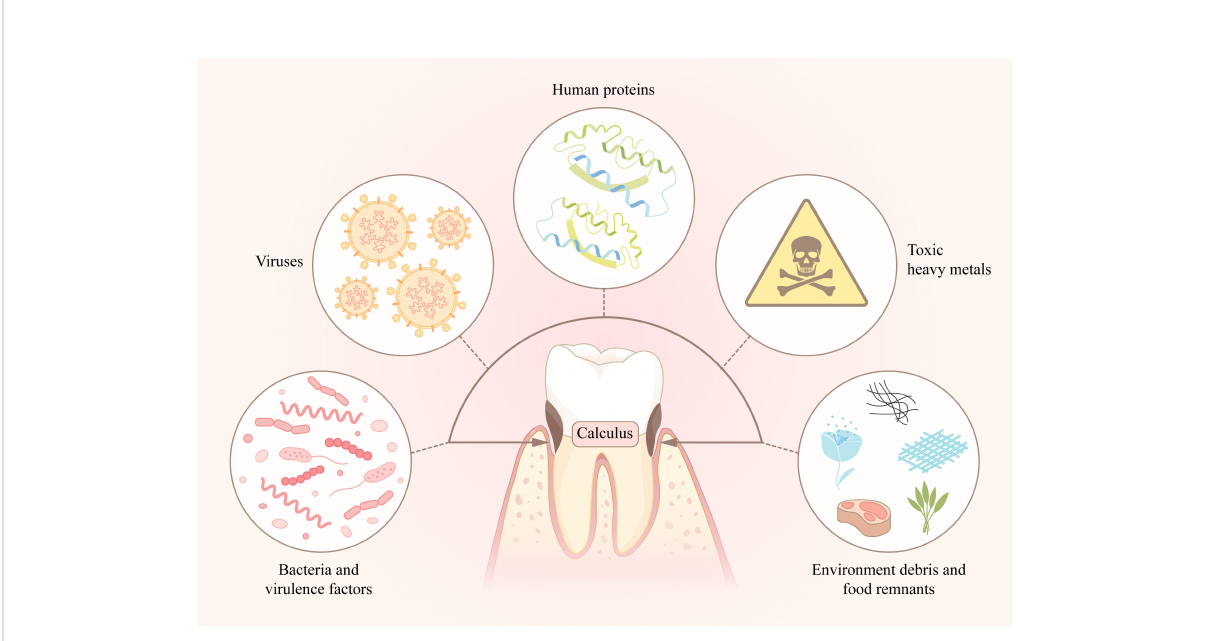
FIGURE 1 The absorbates in dental calculus, including oral bacteria and its virulence factors, human proteins, viruses, toxic heavy metals, environment debris and food remnants, compose the “ storage library ”